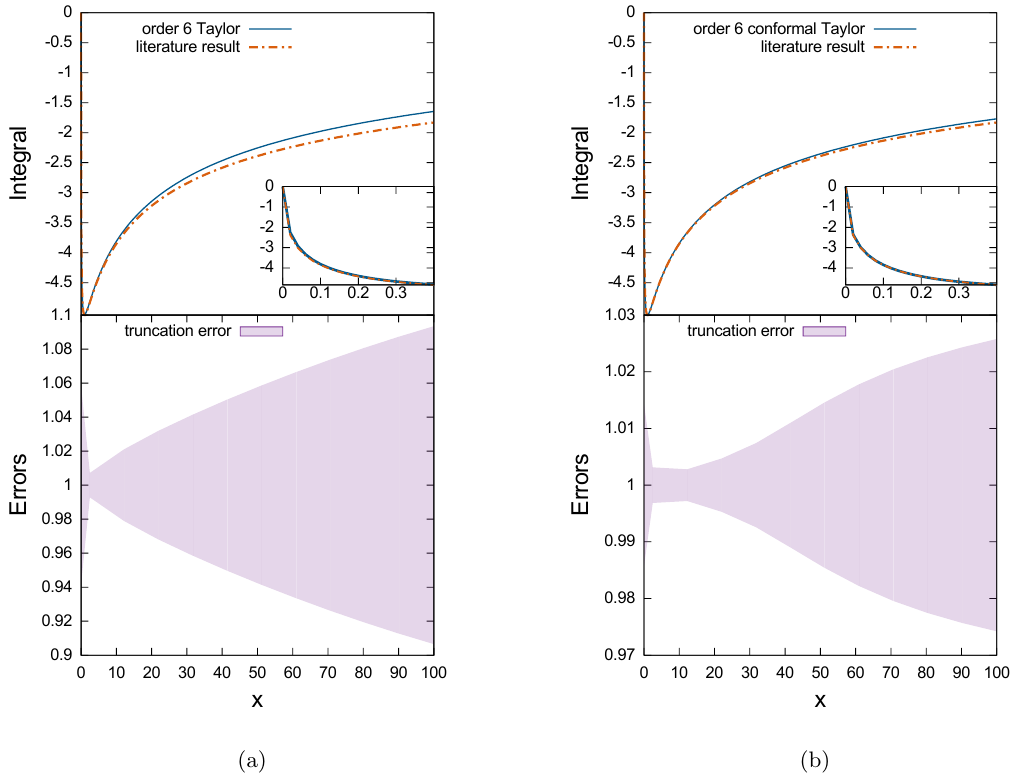
Figure 3 . A comparison between the integrated approximated result for the O ( (cid:15) 0 ) coe(cid:14)cient of T41 and the analytic result, using 3(a) an ordinary Taylor expansion on the integrand, and 3(b) a Taylor expansion enhanced by a conformal mapping. The inlay (cid:12)gures have the same axis labels as the larger